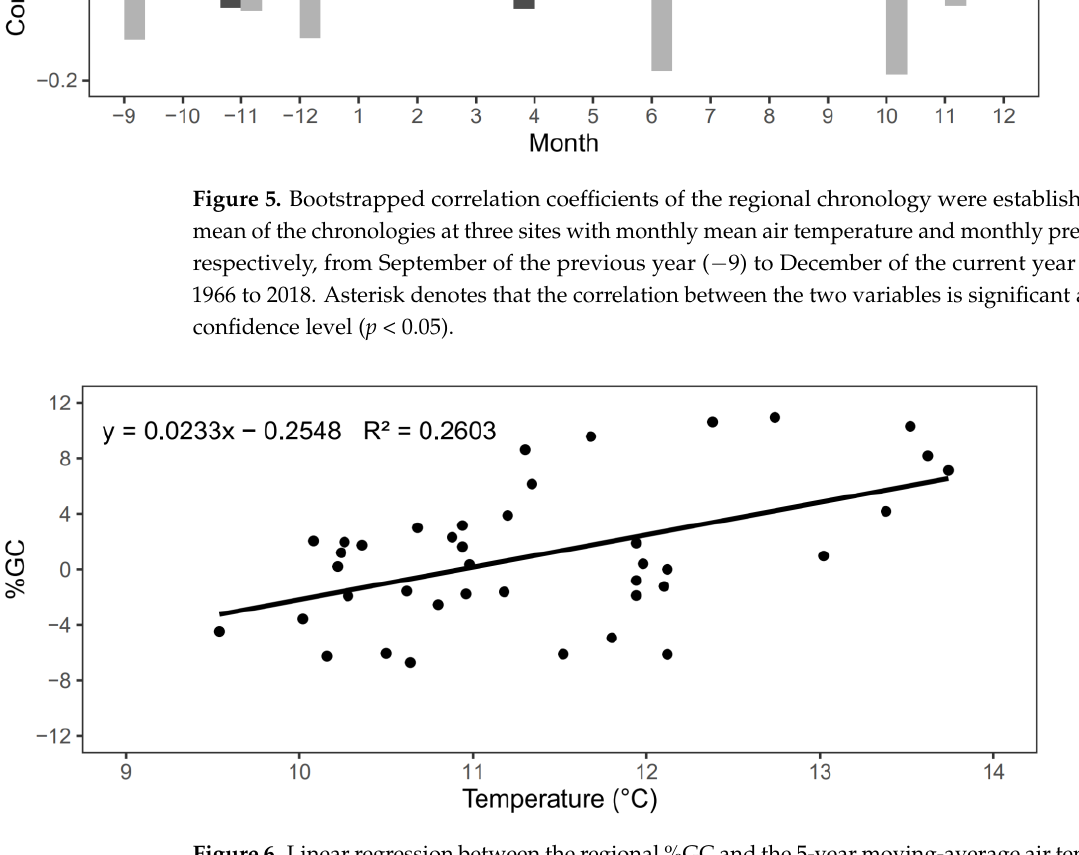
Figure 5. Bootstrapped correlation coefficients of the regional chronology were established by the mean of the chronologies at three sites with monthly mean air temperature and monthly precipita- tion, respectively, from September of the previous year ( −9 ) to December of the current year (12) from 1966 to 2018. Asterisk denotes that the correlation between the two variables is significant at the 95% confidence level ( p < 0.05).